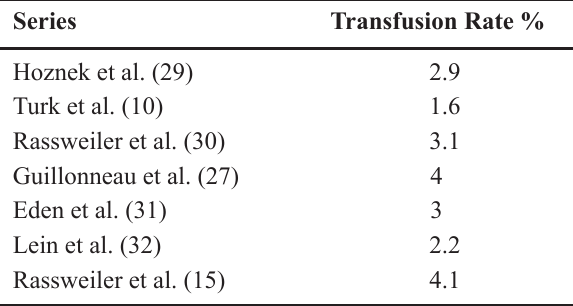
Table 7 – Transfusion